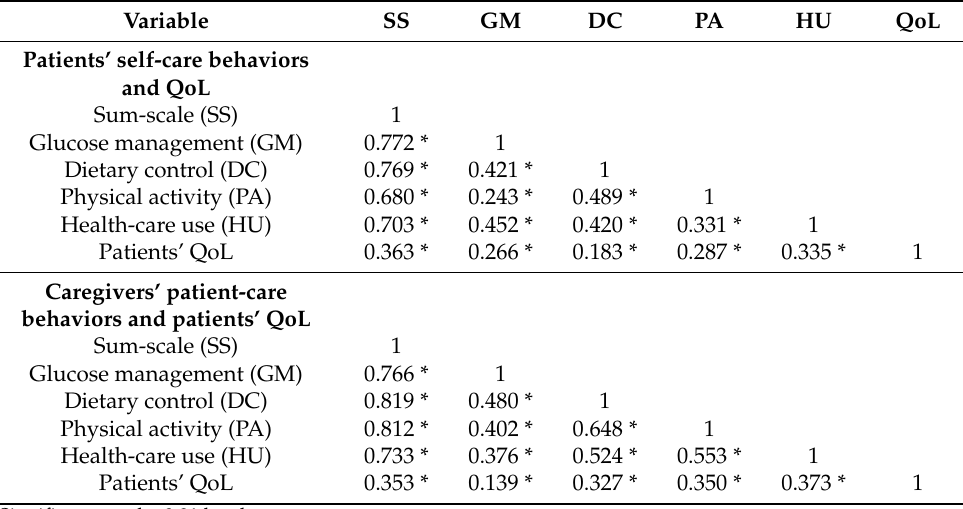
Table 6. Pearson correlation coefficients (r) between patients’ and caregivers’ behaviors classified by subscale and patients’